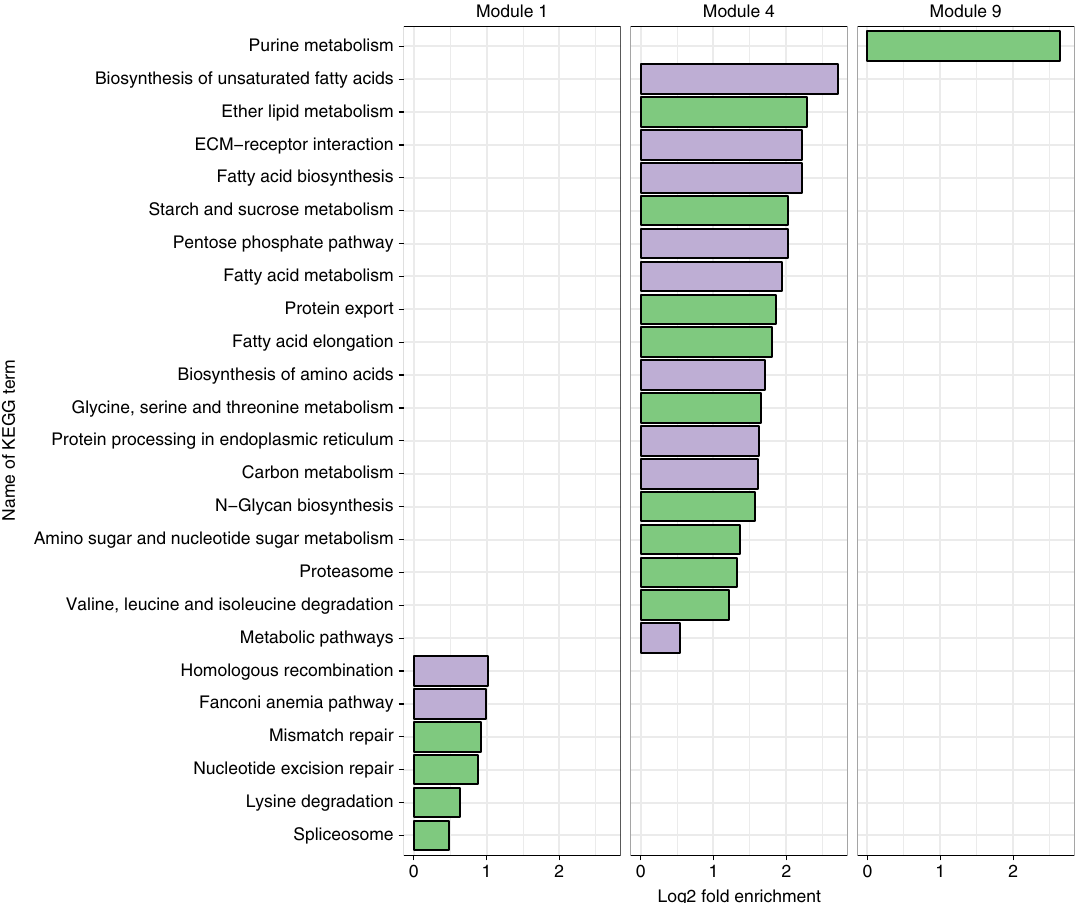
Fig. 4 Results of KEGG pathway enrichment analysis for the genes in each of the three signi fi cantly pheromone-sensitive transcriptional modules. The gene universe was de fi ned as all genes for which we found an ortholog in all four species (i.e. the set that was used to discover these co-expressed modules). All KEGG terms shown in green were signi fi cantly enriched ( p < 0.05), and those shown in purple remained signi fi cant after correction for multiple testing. Fold enrichment was calculated as the proportion of genes associated with the focal KEGG term in the module, divided by the equivalent proportion in the gene universe. Supplementary Figs. 6 – 8 show equivalent results for GO